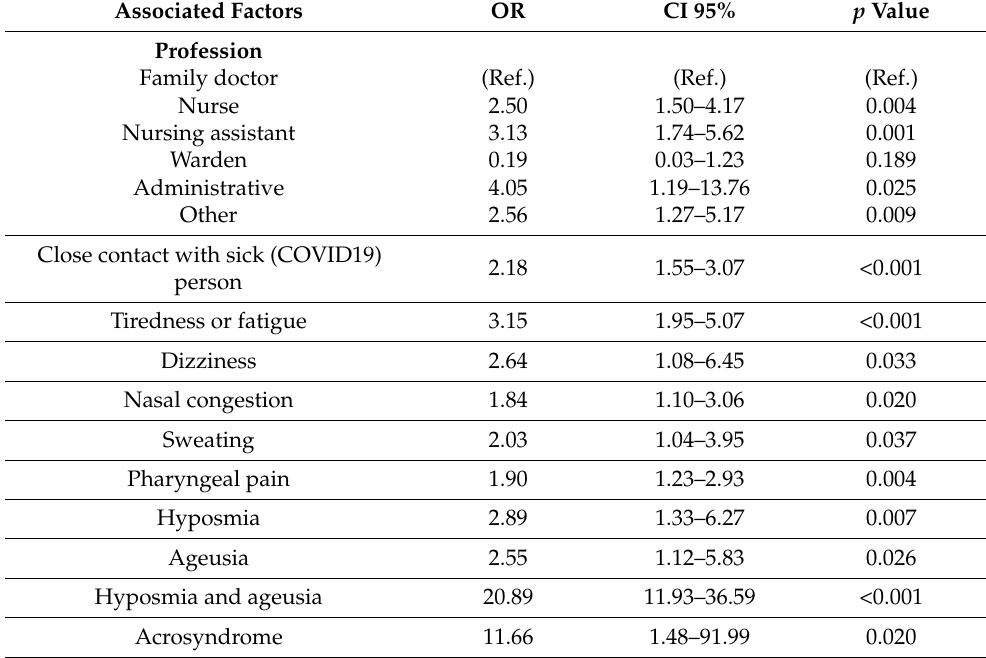
Table 4. Factors associated with SARS-CoV-2 infection by multivariate analysis (binary logistic